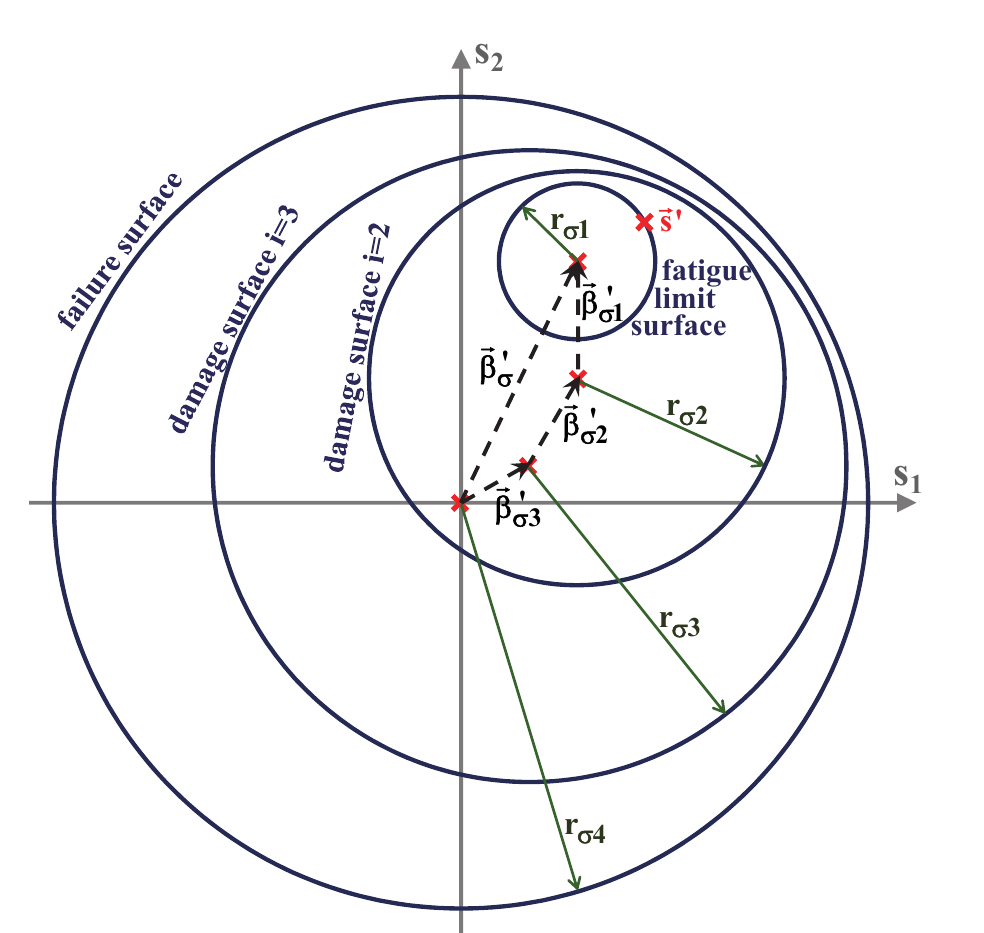
Figure 1: Fatigue limit, damage, and failure surfaces in a 2D deviatoric stress space for three moving nested surfaces, showing the damage backstress vector that defines the location of the fatigue limit surface center, and its three components that describe the relative positions between the centers of consecutive surfaces at each load